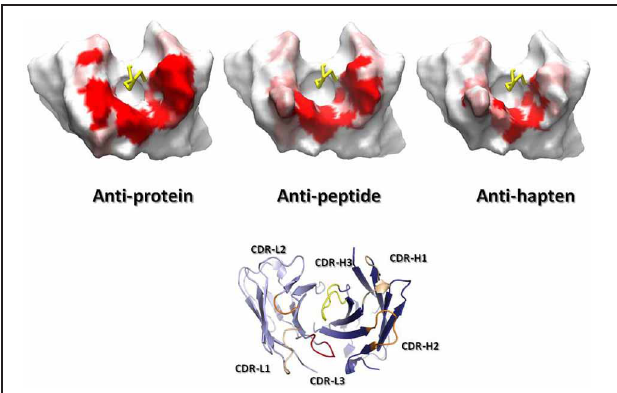
FIGURE 5 | Connolly (1983) surfaces of representative anti-protein, anti-peptide and anti-hapten Fvs, shown from the antigen perspective. A gradient from red (contact) to white (no contact) represents the SDRUs of antibodies recognizing generic ligands. The surfaces were generated by running a 7.0-Å radius probe over the Fv after removing the CDR-H3 loop (yellow ribbon) to better represent the surface common to all antibodies. Note the variation in size of the surface from anti-protein, a large surface, to anti-hapten antibodies, a small one. On the bottom, a ribbon representation of a Fv in the same orientation as the Fvs displaying the Connolly surface to indicate the position of the CDRs. Also note the protruding CDR-L1 in the anti-peptide and anti-hapten Fvs, which modulates the topography of the antigen-binding site. The ribbon figure was generated with PyMol, while the Connolly surface figures were produced using Discovery